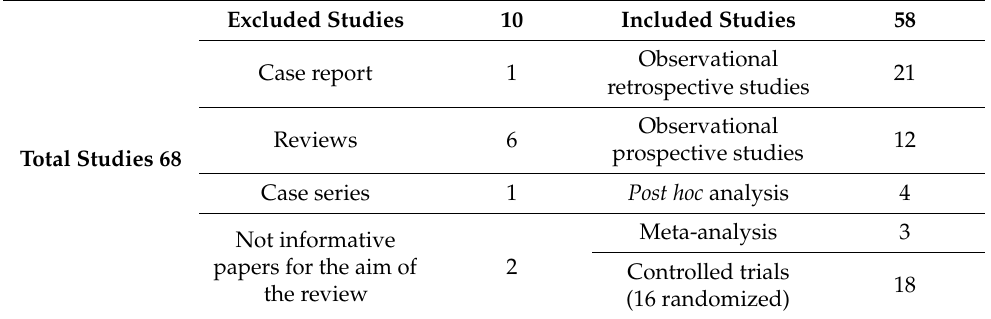
Table 1. Overview of studies selected for systematic review, subdivided according to study